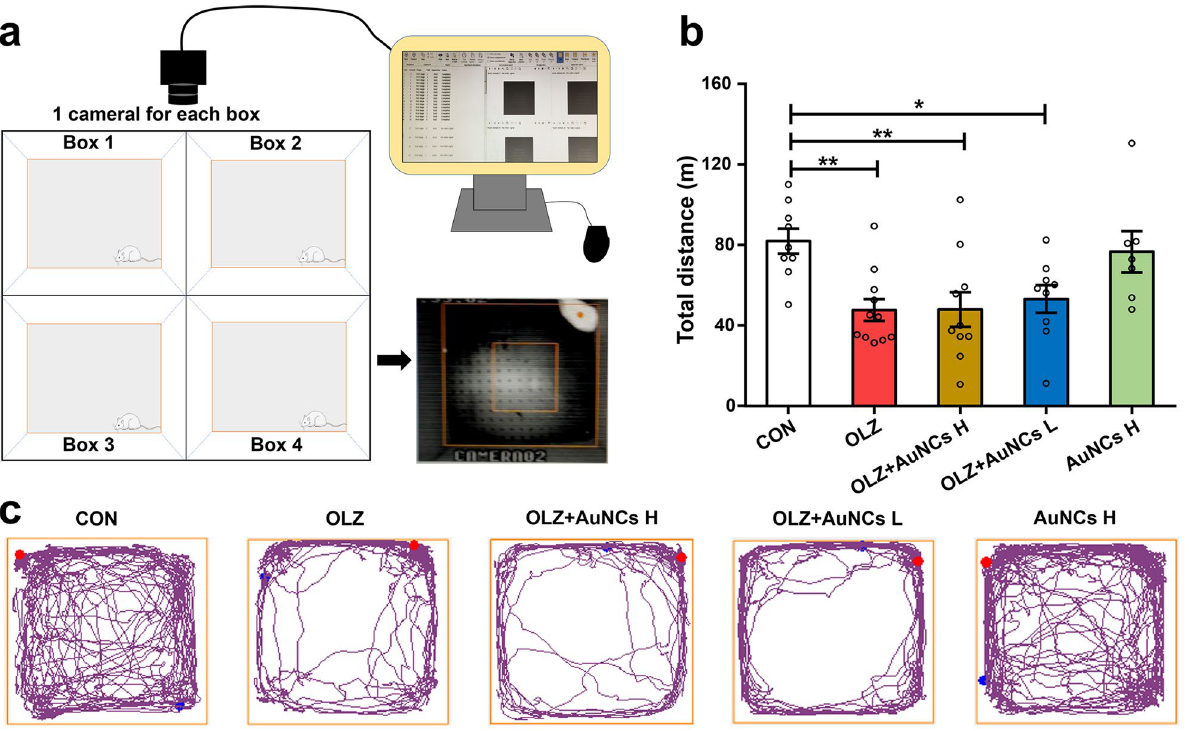
Figure 5. Effects of olanzapine and AuNCs co-treatment on the locomotor activity of rats. ( a ) Experimental procedure of locomotor activity test in rats. ( b ) Total distance of rats in the open field test. ( c ) Examples of locomotor activity rhythm of rats treated with olanzapine and AuNCs. n = 7–11/group. All data were presented as mean ± SEM. * p < 0.05, ** p < 0.01, OLZ, OLZ + AuNCs H, OLZ + AuNCs L vs . Fig. S9 from S9-16 to S9-20). These results demonstrated that AuNCs could reverse the olanzapine induced reduction of BAT thermogenesis through increasing the expression of UCP-1, PGC-1α, PPAR-α and PPAR-γ.